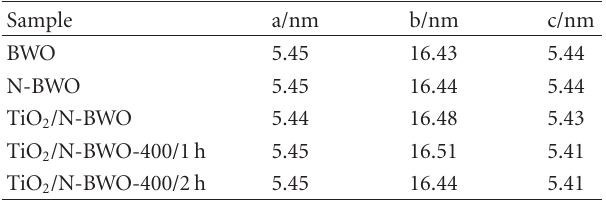
Table 2: Crystal lattice cell parameters of Bi 2 WO 6 in the as- synthesized